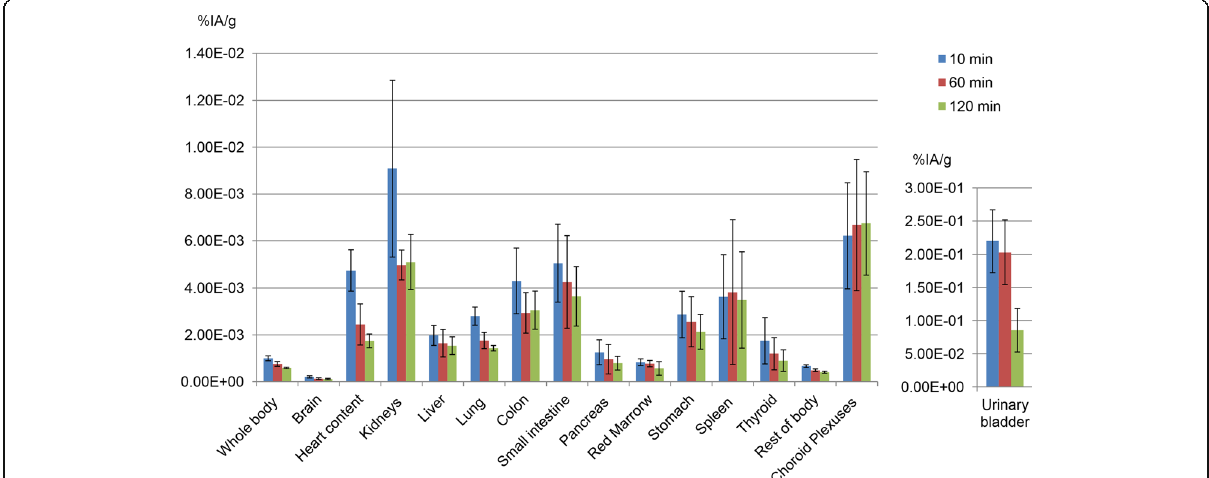
Fig. 4 Organ time-activity curves corrected for 68 Ga physical decay. These data essentially show the biological organ kinetics of 68 Ga-NODAGA- RGDyK during the observation time. Colour bars represent the average percent of injected activity per gram of tissue (%IA/g) ± standard deviation